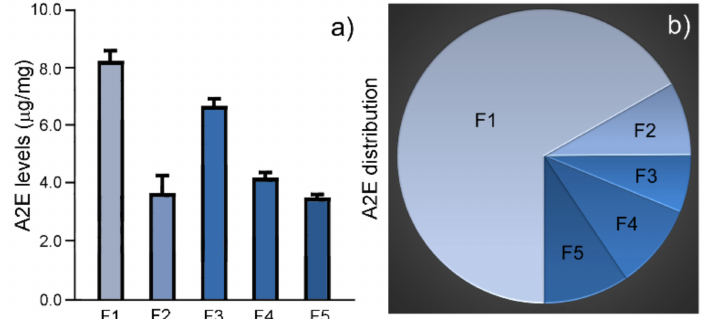
Figure 5. A2E levels and distribution. The A2E level in 1 mg of granules of each fraction was quantified by LC / MS. The highest A2E level was found in F1, followed by the level in F3 ( a ). F1 also accounts for the largest proportion of A2E distribution in the 5 fractions of RPE granules ( b